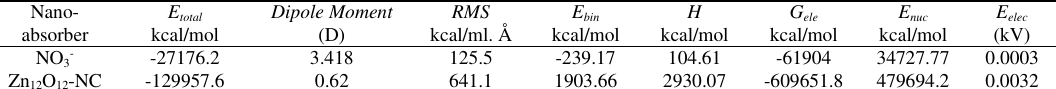
Table 1. The structural and thermodynamic parameters of nitrate and zinc oxide nano-cages at 298K.